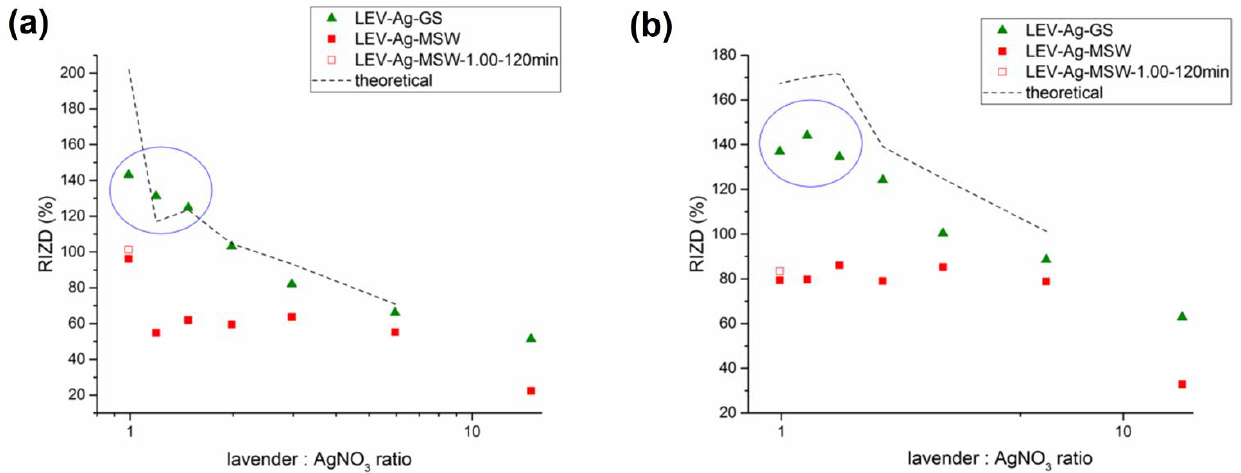
Figure 10. Antibacterial activity of green-synthesized (GS) and washed mechanochemically synthesized (MSW) Ag nanoparticles using lavender. The activity is presented as relative inhibition zone diameter (RIZD) against bacteria ( a ) E. coli and ( b ) S. aureus as a function of lavender:AgNO 3 ratio. The dash line describes the hypothetical antibacterial activity if all silver introduced into the reaction would be stabilized (based on the Ag contents determined from atomic absorption spectrometry (AAS). Blue circles show the regions, where the silver nitrate certainly contributes to the antibacterial action of the GS samples.